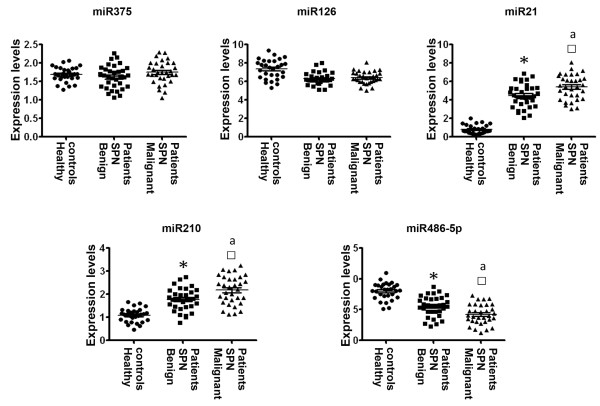
Comparison of plasma miRNA expressions in healthy smokers, patients with benign SPNs, and patients with malignant SPNs. Horizontal lines indicate mean values. *, statistical significance (P < 0.05) between patients with benign SPNs and healthy controls. □, statistical significance (P < 0.05) between patients with malignant SPNs and healthy controls. ª, statistical significance (P < 0.05) between patients with malignant SPNs and patients with benign SPNs.